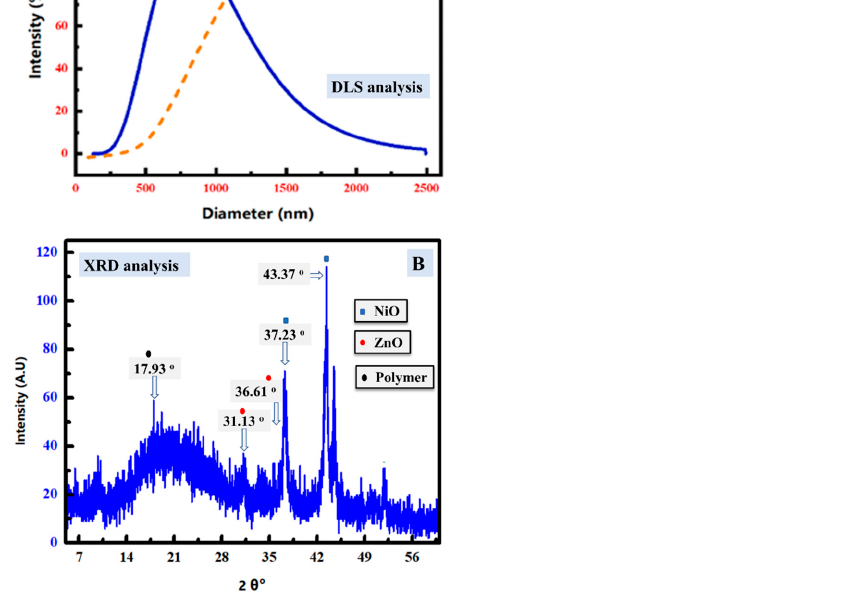
Figure 2. ( A ) DLS analysis of ZnNiO@PANE composite (the orange dotted line) and its differential analysis to indicate the peak (the blue line), ( B ) XRD analysis of ZnNiO@PANE composite.